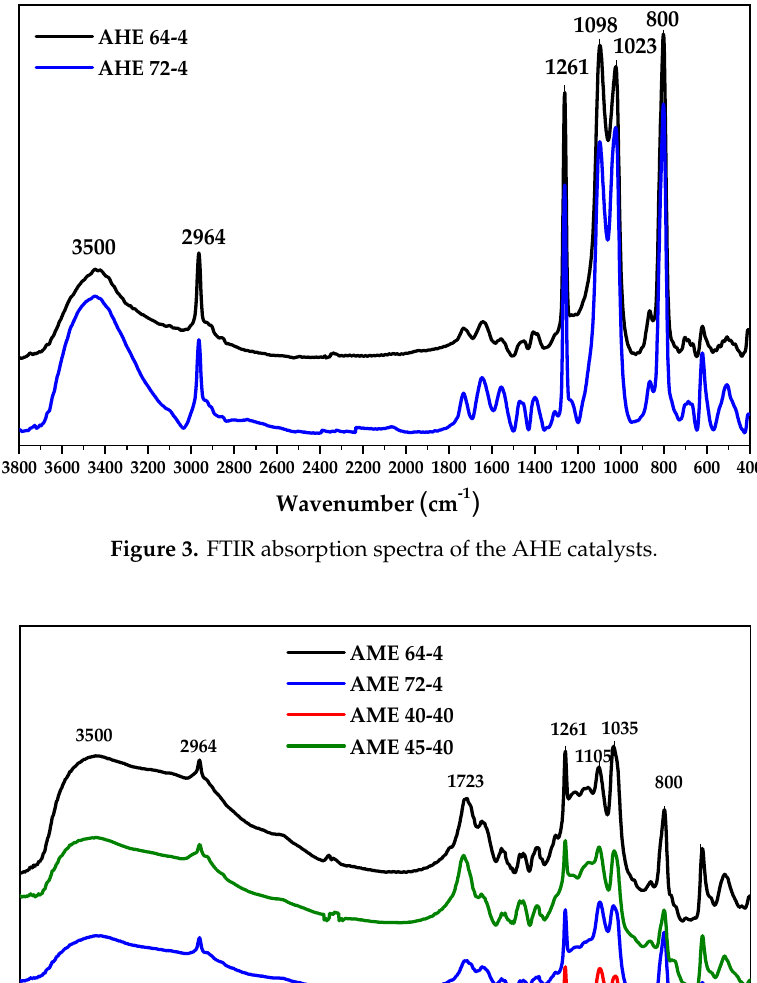
Figure 4. FTIR absorption spectra of the AME catalysts.